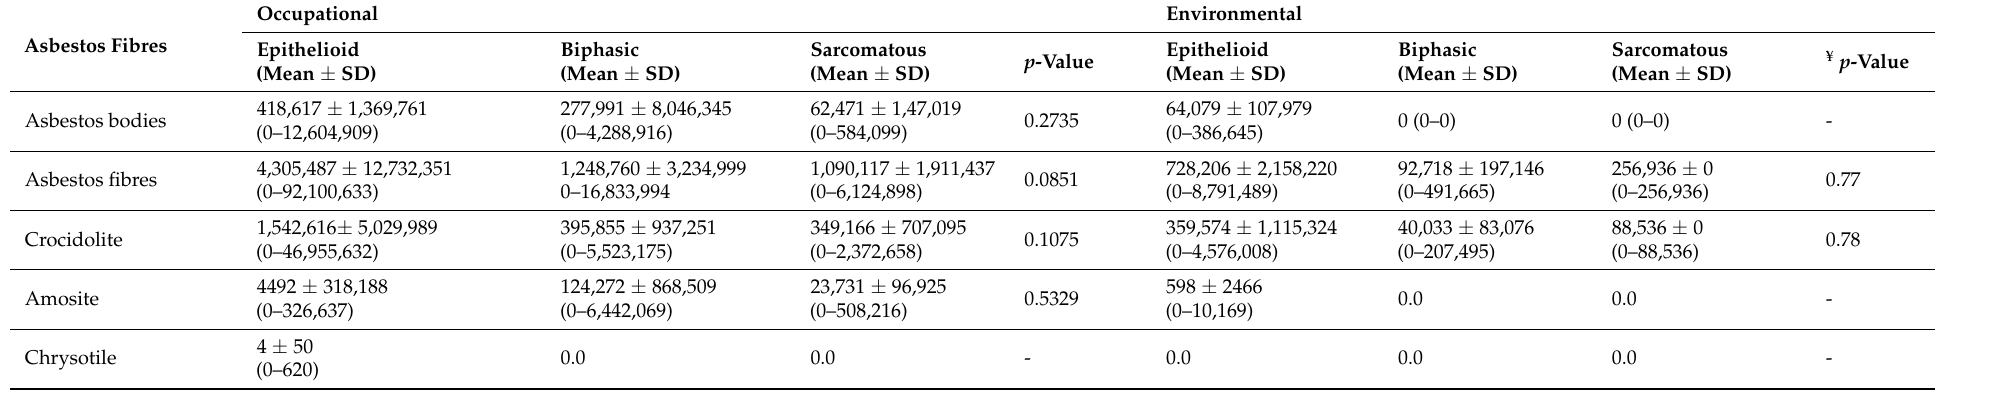
Table 7. Asbestos bodies and fibre counts per mesothelioma subtype (millions per gm of dried lung).